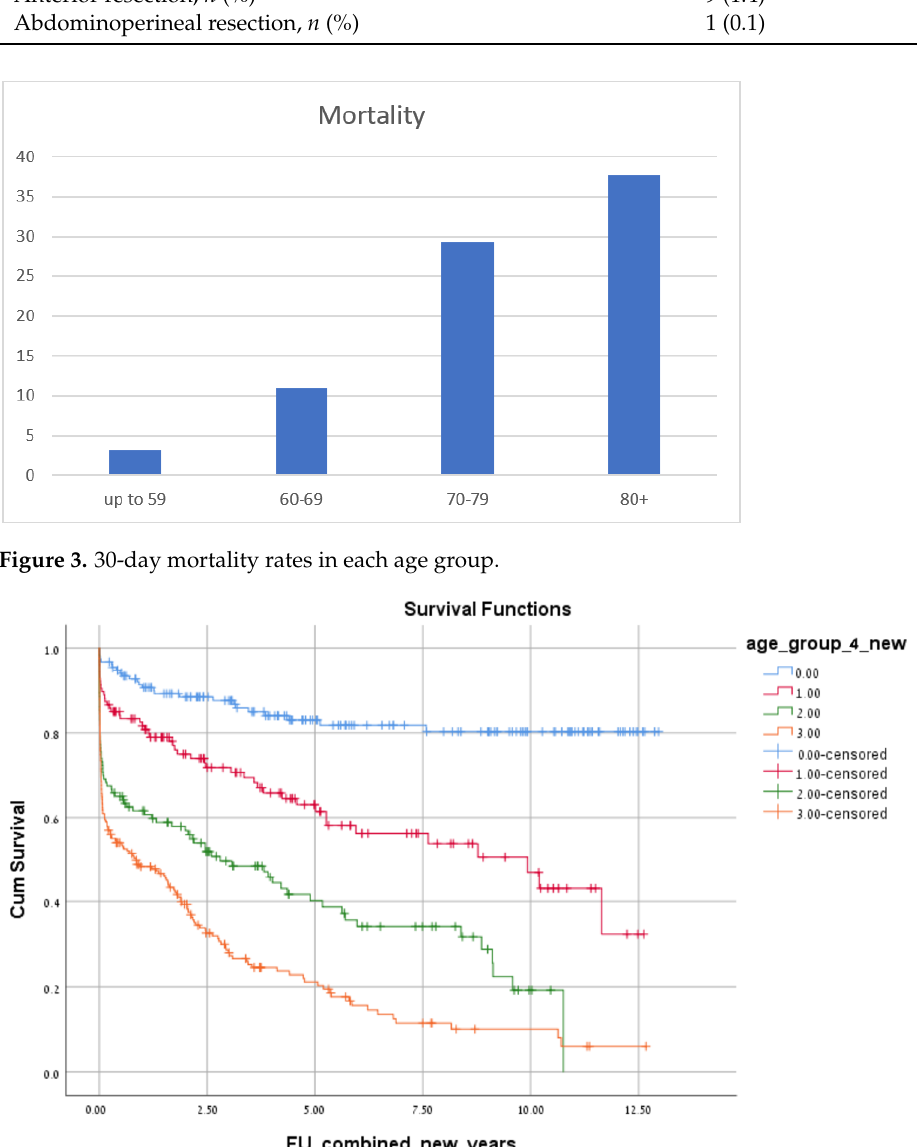
Figure 2. Surgeries in each age group.